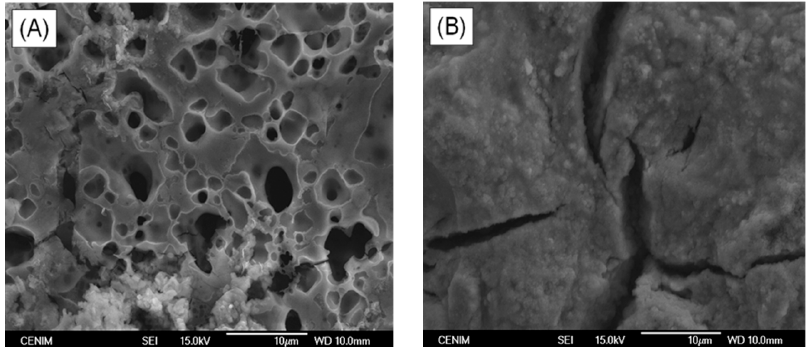
Figure 9. SEM micrographs obtained for the HAp-coatings/Ti6Al4V system thermally treated at ( A ) 600 °C/2 h; ( B ) 800 °C/2 h before immersion in SBF.